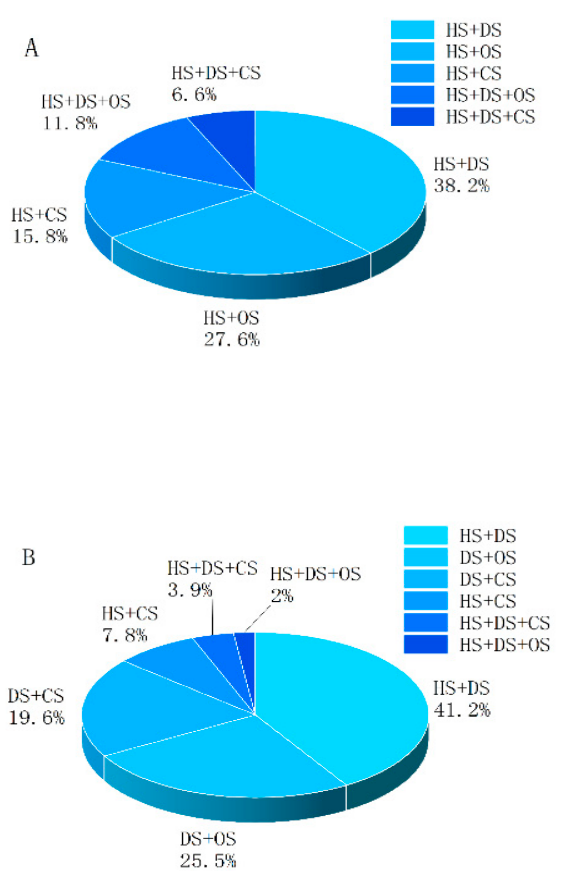
Figure 3. Combinations and relative frequencies of multifactorial shock in polytrauma patients in ( A ) the early phase and ( B ) the middle phase. HS: hypovolemic shock; DS: distributive shock; CS: cardiogenic shock; OS: obstructive shock. Table 4. Combinations and relative frequencies of multifactorial shock in different phases after pol- ytrauma. Combinations